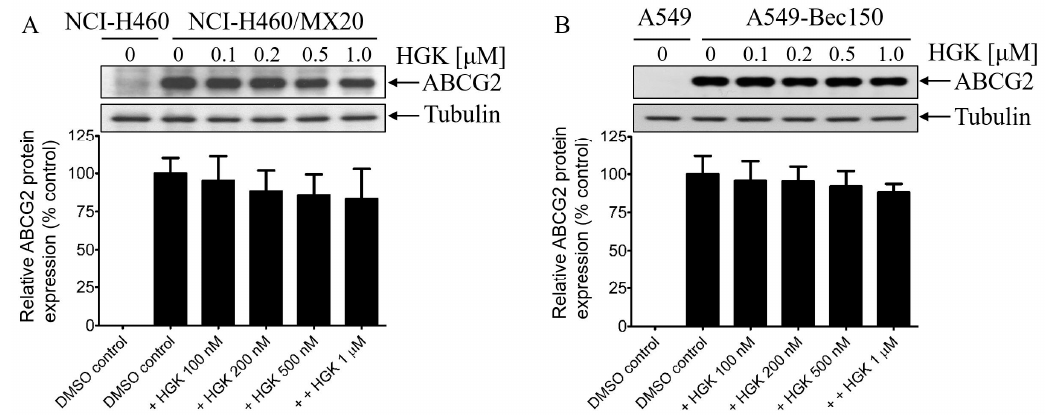
Figure 5. Hydroxygenkwanin does not alter the protein expression of ABCG2 in multidrug-resistant cancer cells. The ABCG2-overexpressing ( A ) NCI-H460/MX20 and ( B ) A549-Bec150 cancer cells were treated with DMSO (vehicle control) or hydroxygenkwanin (HGK) at 100 nM, 200 nM, 500 nM, or 1.0 µ M for 72 h, and the cell lysates were processed for immunoblot detection and quantification, as described in the Section 4. Representative Western blots (top), and the corresponding quantification (bottom) of the human ABCG2 protein and α -tubulin as the internal loading control, are shown. Values are presented as the mean ± SD were obtained from at least three independent experiments.